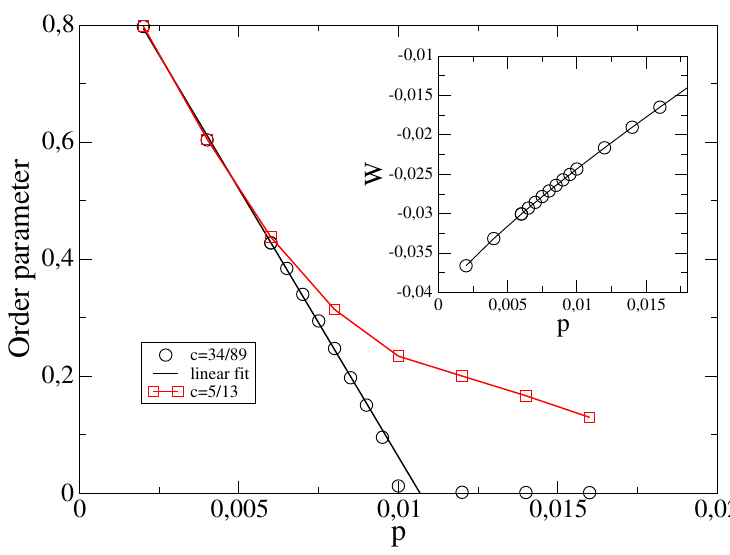
Figure 19: Order parameter of the Aubry transition as a function of pressure defined as the largest gap in the envelope function, see Figs. 17. Inset: no abrupt change in energy nor in its first derivative. Here λ = 1.90, ξ =